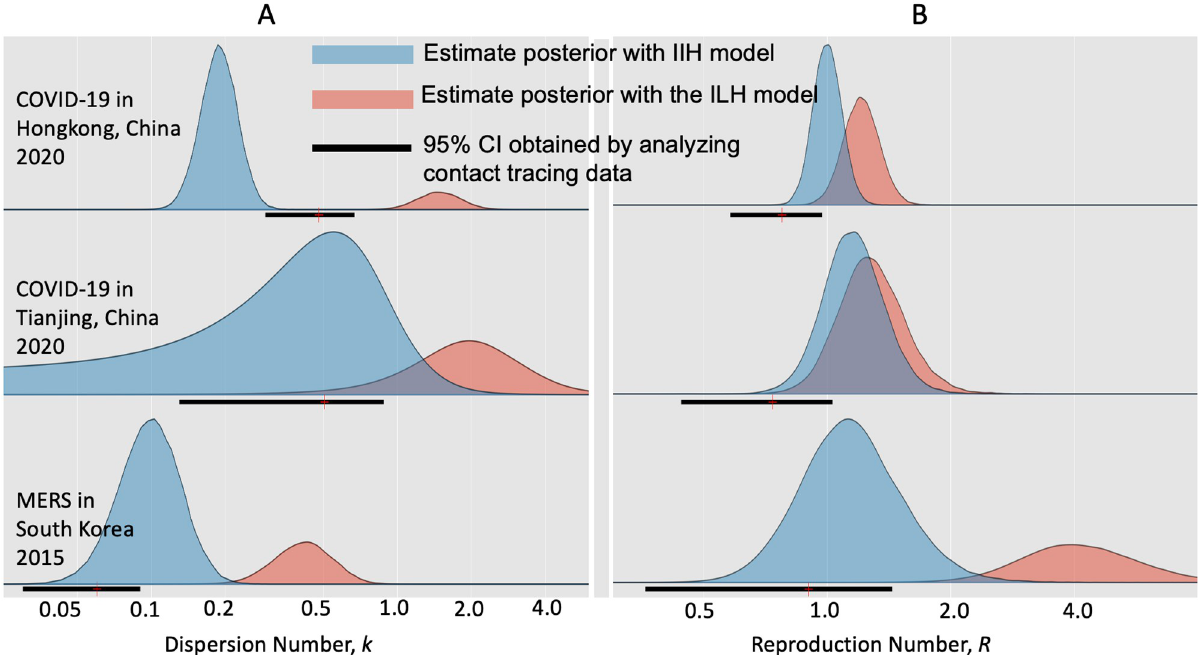
Fig 2. Comparison of estimating transmission dynamics of three epidemics with the instant-individual heterogeneity (IIH) model and the instant-level heterogeneity (ILH) model in [22]. During each epidemic, transmission dynamics (i.e., reproduction number R and dispersion number k ) were assumed constant. Colored areas showed the posteriors of the estimates by analyzing incidence times series. Black solid lines represented the estimates in literatures obtained by analyzing the contact tracing data of these epidemics [10, 33, 34]. A: Estimation of reproduction number ( R ); B: Estimation of dispersion number ( k